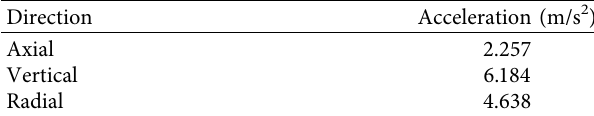
Table 14: Vibration test results after optimization. Direction